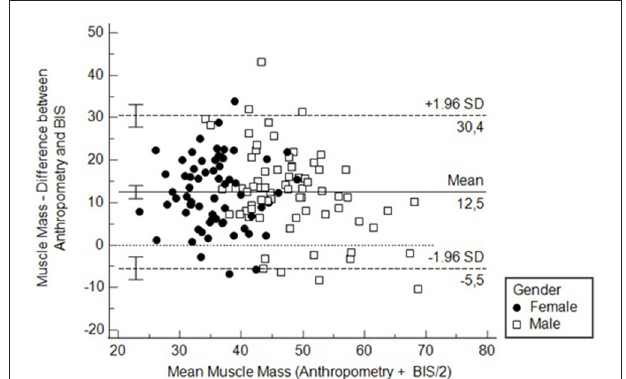
FIGURE 5 | Bland-Altmann curve to assess the agreement between BIS and anthropometry for measuring muscle mass. MMA, Muscle mass measured by anthropometry; MMB, Muscle mass measured by bioimpedance